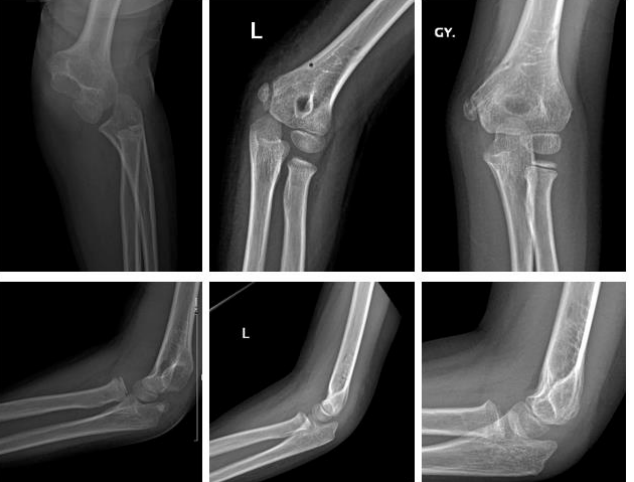
Figure 4. Fracture of medial epicondyle with ActivaPin TM : preop, 1 day postop, 6 months postop (left to right).